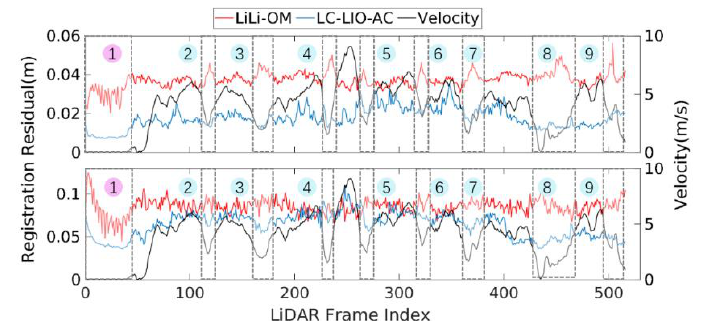
Figure 10. The final LiDAR scan-to-map registration residual of feature points when the registration converges on each frame of LiLi-OM and LC-LIO-AC that are corresponding in time in the urban canyon 1. The black line represents the velocity of these frames calculated by LC-LIO-AC. The gray boxes marked from 1 to 9 correspond to the nine places marked in Figure 8a. The top and bottom panels represent the residual for plane and edge points, respectively.